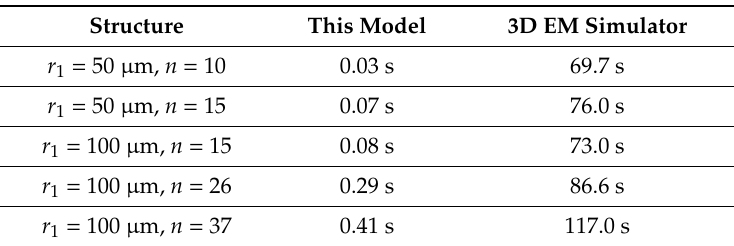
Table 2. Comparison of computational e ffi ciency.